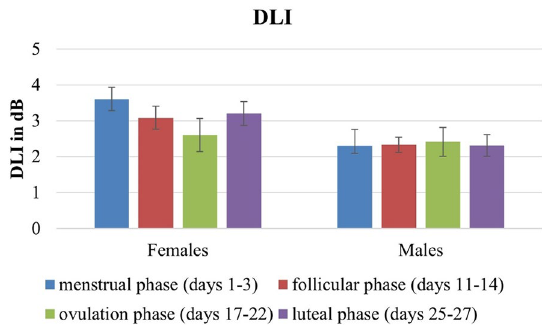
Fig. 1 The mean and standard deviation of scores obtained for DLI in males and females